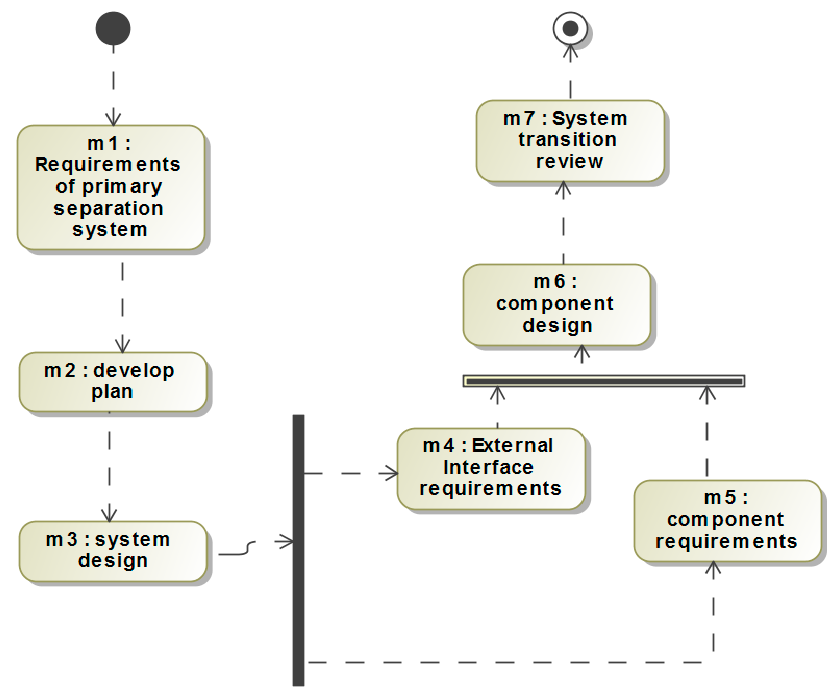
Figure 3. When requirements are proposed.